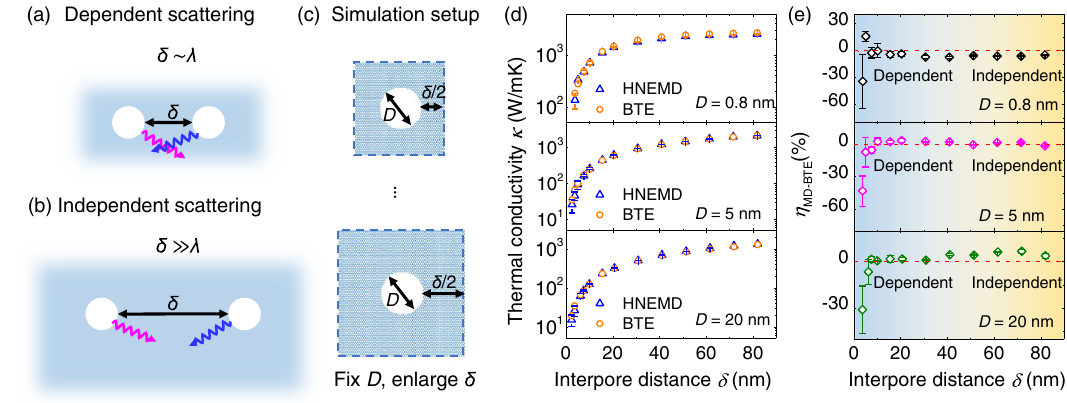
Fig. 2 The crossover from dependent to independent phonon-pore scattering. a The schematic of dependent phonon-pore scattering. Dependent phonon-pore scattering refers to the situation when the interpore distance is comparable to the phonon wavelength ( δ ~ λ ) that the interference among scattered waves from nearby pores will prevail. b The schematic of independent phonon-pore scattering. Independent phonon-pore scattering refers to the situation when the pores are suf fi ciently distant ( δ >> λ ) that the interference effect can be safely neglected. c The simulation setup for studying the crossover from dependent to independent phonon-pore scattering. There is one pore located at the center of the simulation domain with increasing interpore distance. The pore size is fi xed. Periodic boundary conditions are applied to the boundaries of the domain. d The thermal conductivities of porous graphene at different interpore distances computed by HNEMD and phonon BTE. e The relative difference between HNEMD and BTE computed thermal conductivities with respect to the interpore distance. The light blue and light yellow regions denote the dependent and independent regimes,